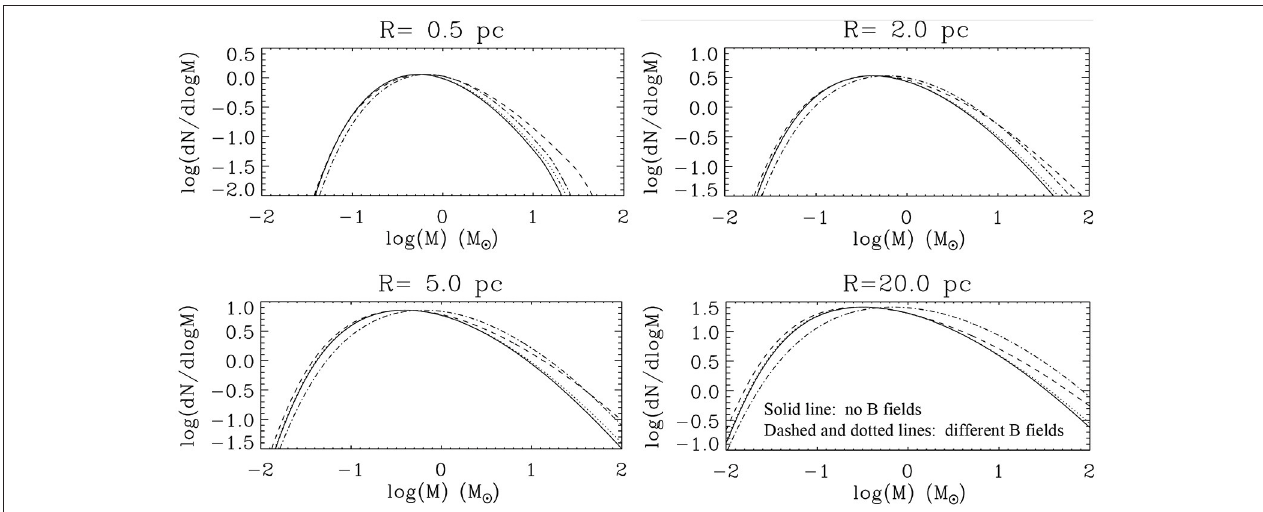
FIGURE 6 | Analytic predictions of the core mass function with and without magnetic fields for different cloud radii, R without magnetic fields. The dotted line is for B B 10 µ G[ n / (1,000cm − 3 )] 0.3 , where n is the molecular hydrogen number density. Figure adopted from Hennebelle and Chabrier =